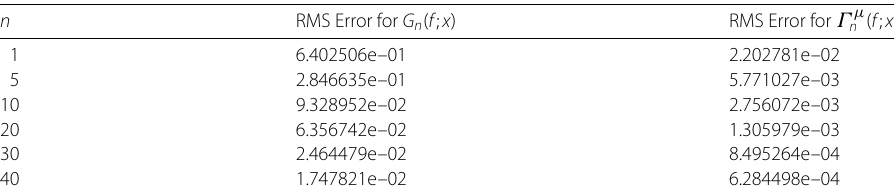
Table 1 Root-mean-square errors for classical Gamma operators and newly constructed Gamma operators with μ = 0.25 for different values of n , test function f ( x ) = x log(1+ x ) , on an equally